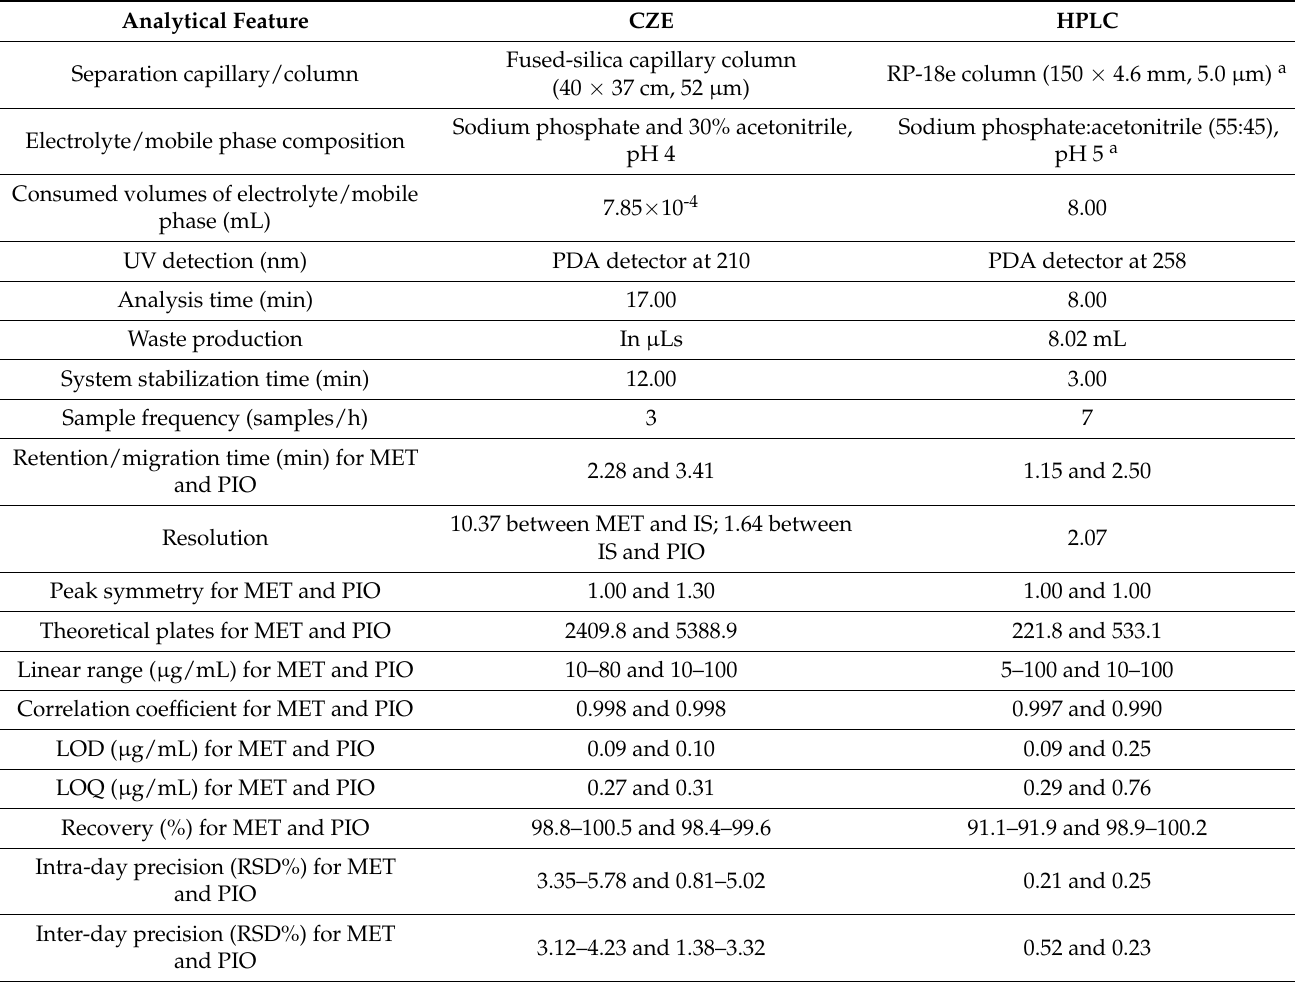
Table 4. Comparison of the proposed capillary zone electrophoretic method with a